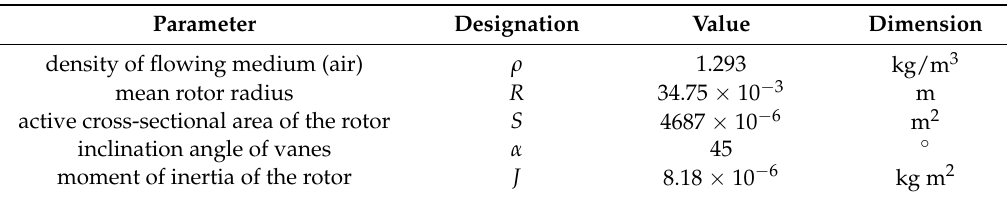
Table 1. Physical parameters of vane